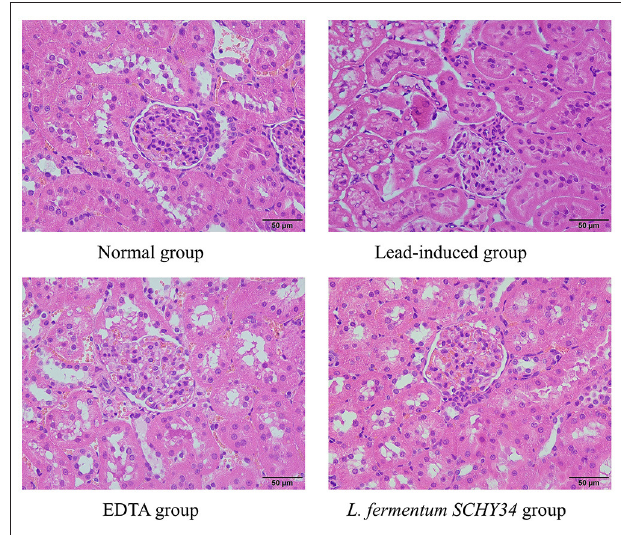
FIGURE 2 | Pathological observation of liver tissue in SD rats (H&E).